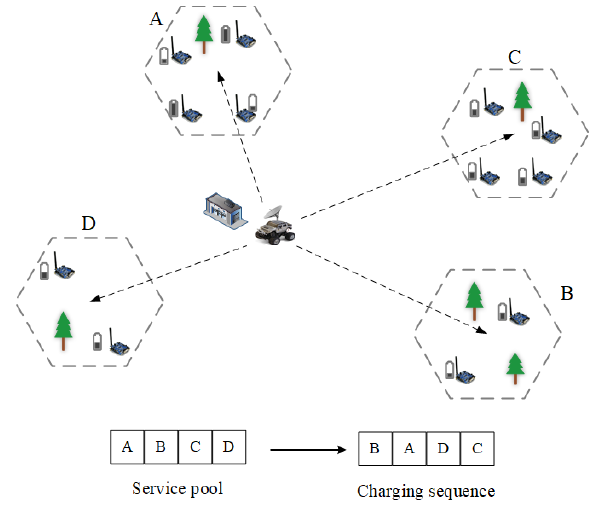
Figure 3. Charging sequence optimization.